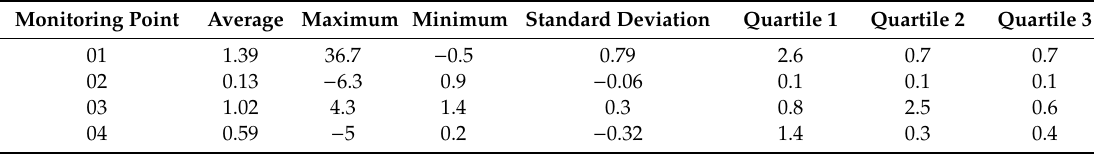
Table 5. Variation of description statistics between two monitoring periods / dB(A).